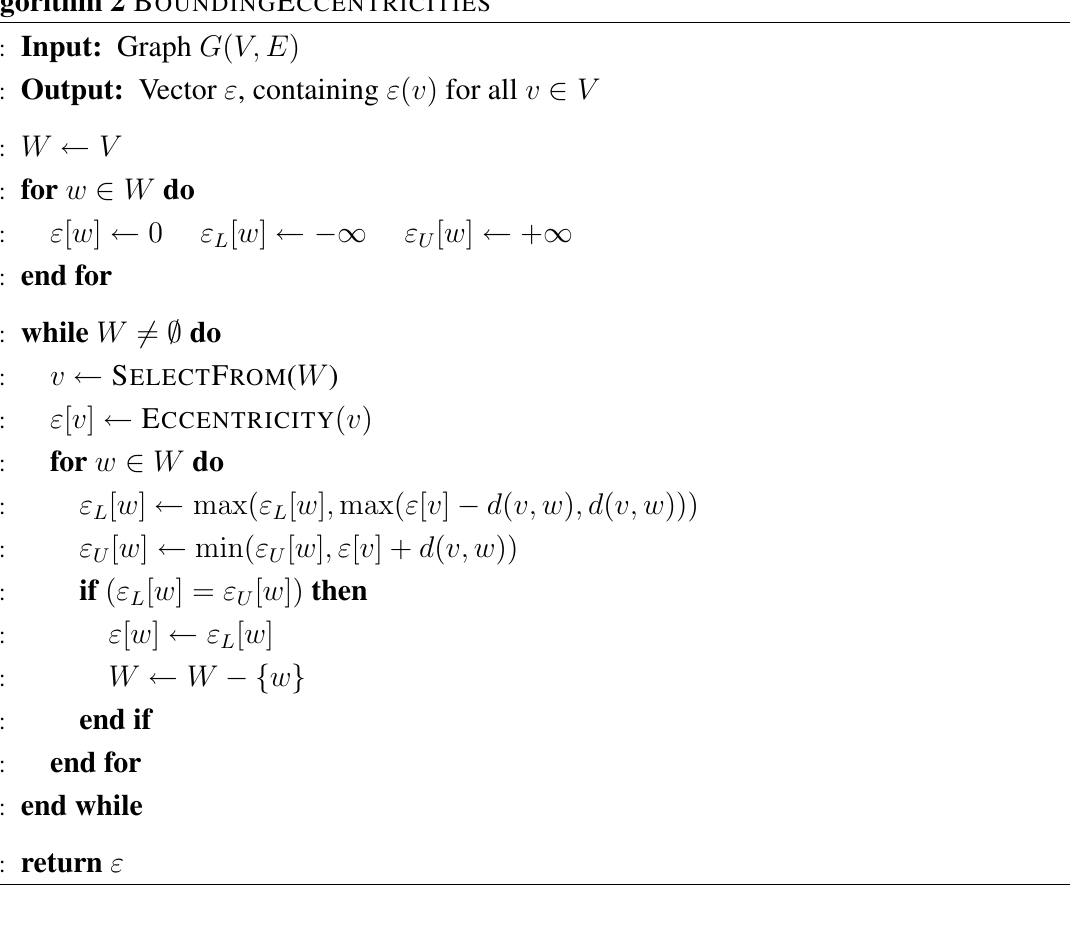
Figure 3. Eccentricity bounds of the toy graph in Figure 2 after subsequently computing the eccentricity of node G (left) and node E